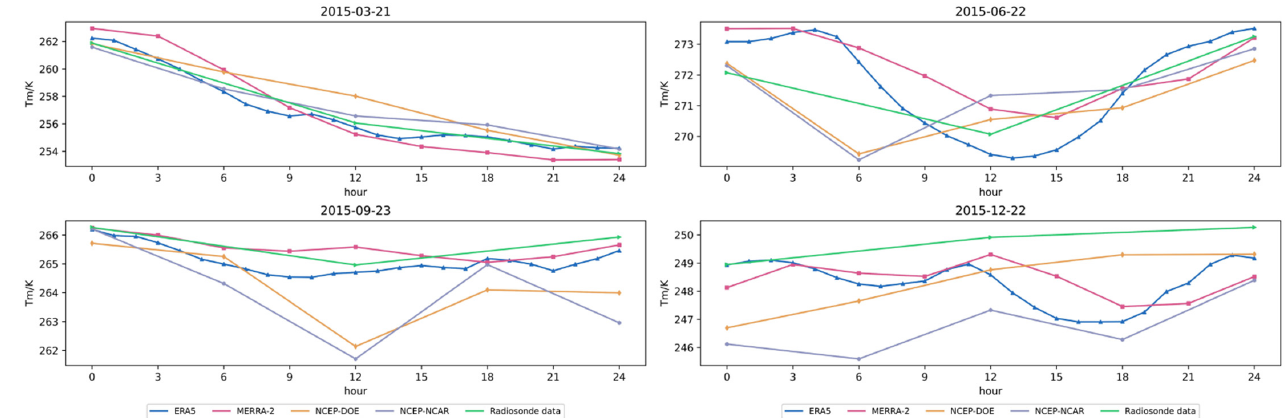
Figure 6. T m of the vernal equinox, summer solstice, autumn equinox, and winter solstice in 2005 at station 04220, with the highest temporal resolution from the four reanalysis data.